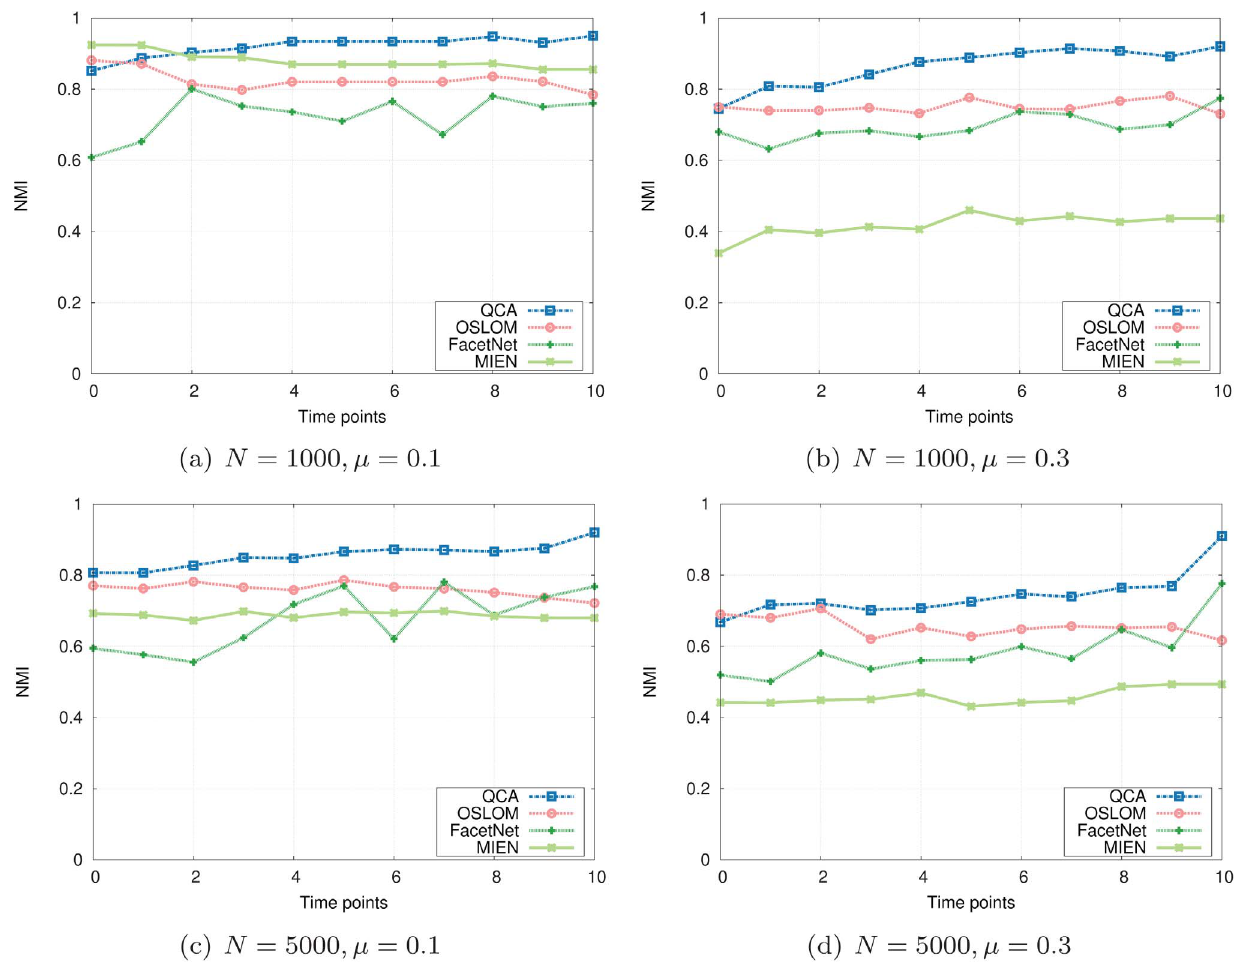
Figure 3. NMI scores on synthesized networks with known communities.